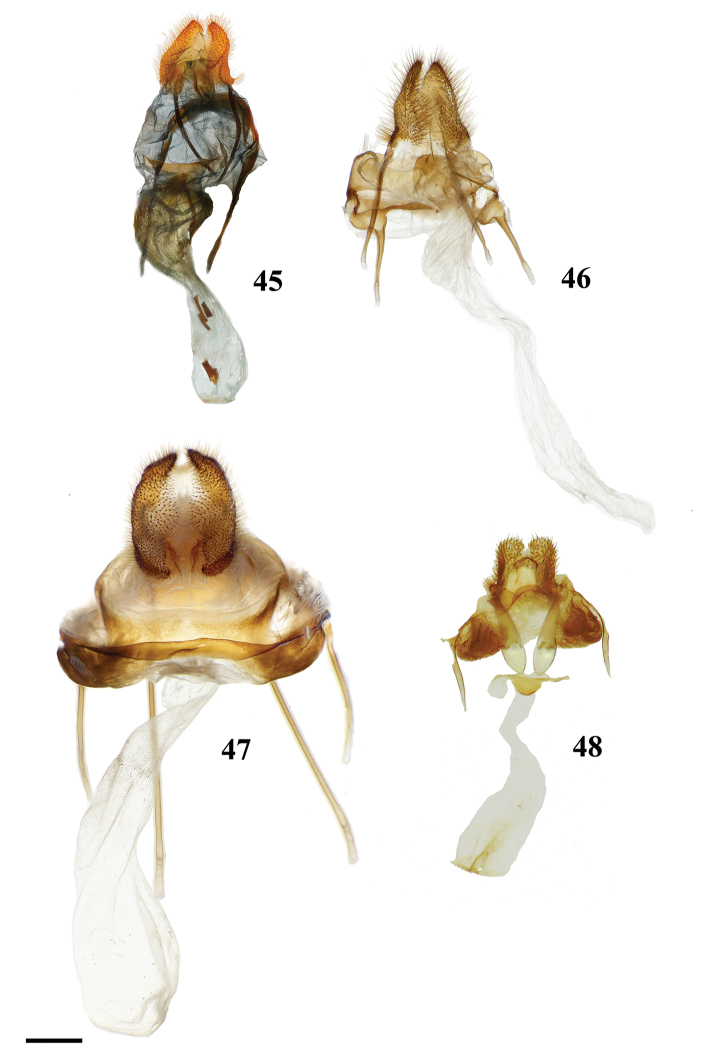
Ventral view of female genitalia of type species (except where noted) of genera belonging to Mimalloninae. 45Eadmunaesperans, St Laurent diss.: 2-12-16:1 (NHMUK) 46Macessogacffabia, genitalia vial NHMUK 010402337 (NHMUK) 47Mimalloamilia, St Laurent diss.: 3-31-18:2 (MGCL) 48Tostalloalbescens, St Laurent diss.: 10-21-15:5 [reused with permission from St Laurent and Mielke (2016), ZooKeys] (NHMUK). Scale bar: 1 mm.